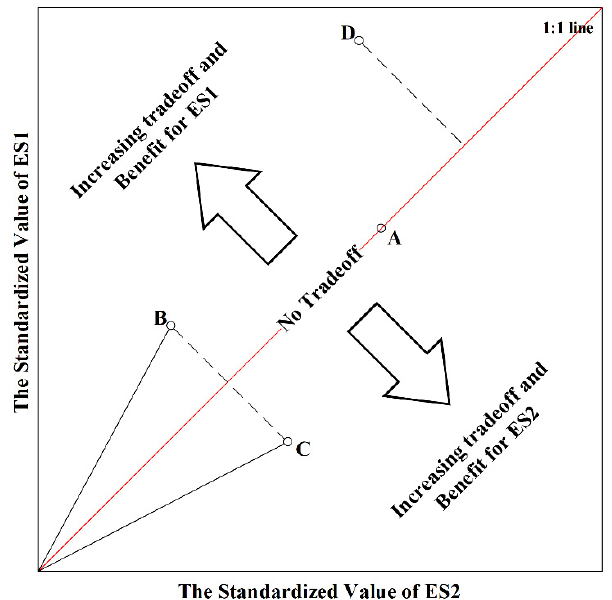
Figure 4. Quantitative expression of the trade-off intensity between two ESs. There is no tradeoff between the two ecosystems at point A. The tradeoff is stronger at point D than those at points B and C. The equal distance between points B and C and the 1:1 line indicates that the trade-off intensity is the same at both points, but B is more beneficial to ES1, and C is more beneficial to ES2. This figure was adapted from a previous study [54].